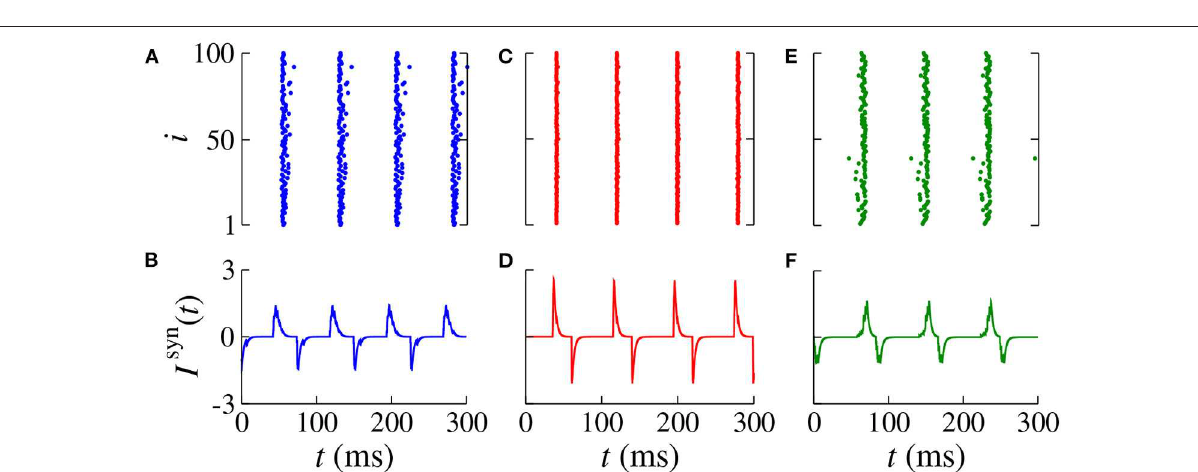
Frontiers in Physiology |